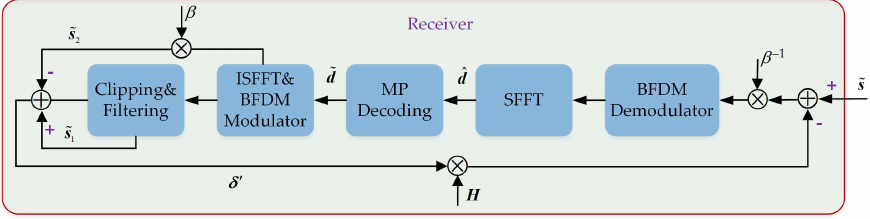
Figure 3. The iterative cancellation of clipping noise for OTFS-BFDM signals on the